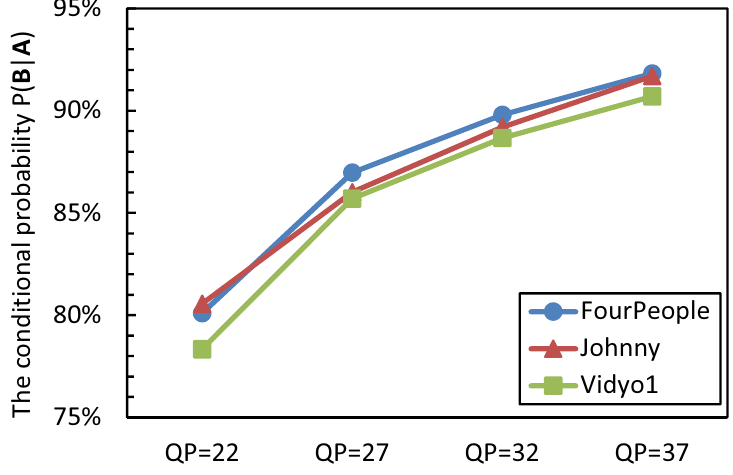
Figure 2. The conditional probability P( B | A